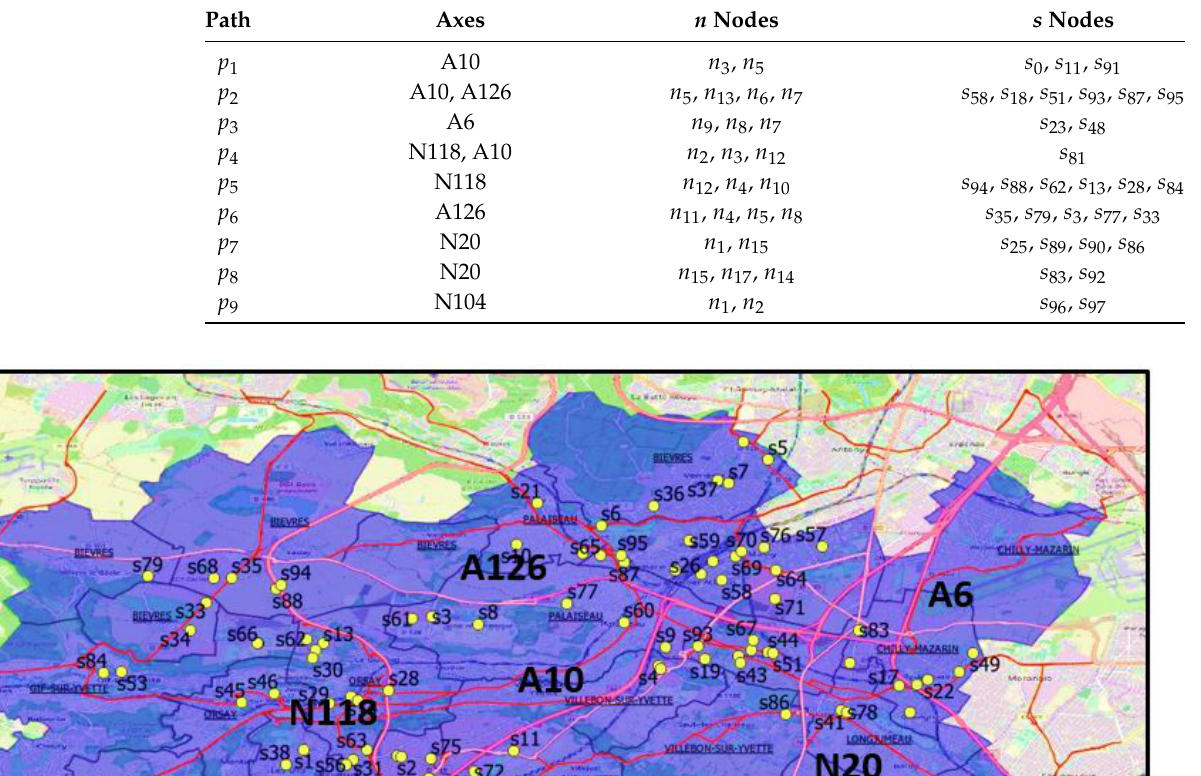
Table 4. Defined mobility paths.